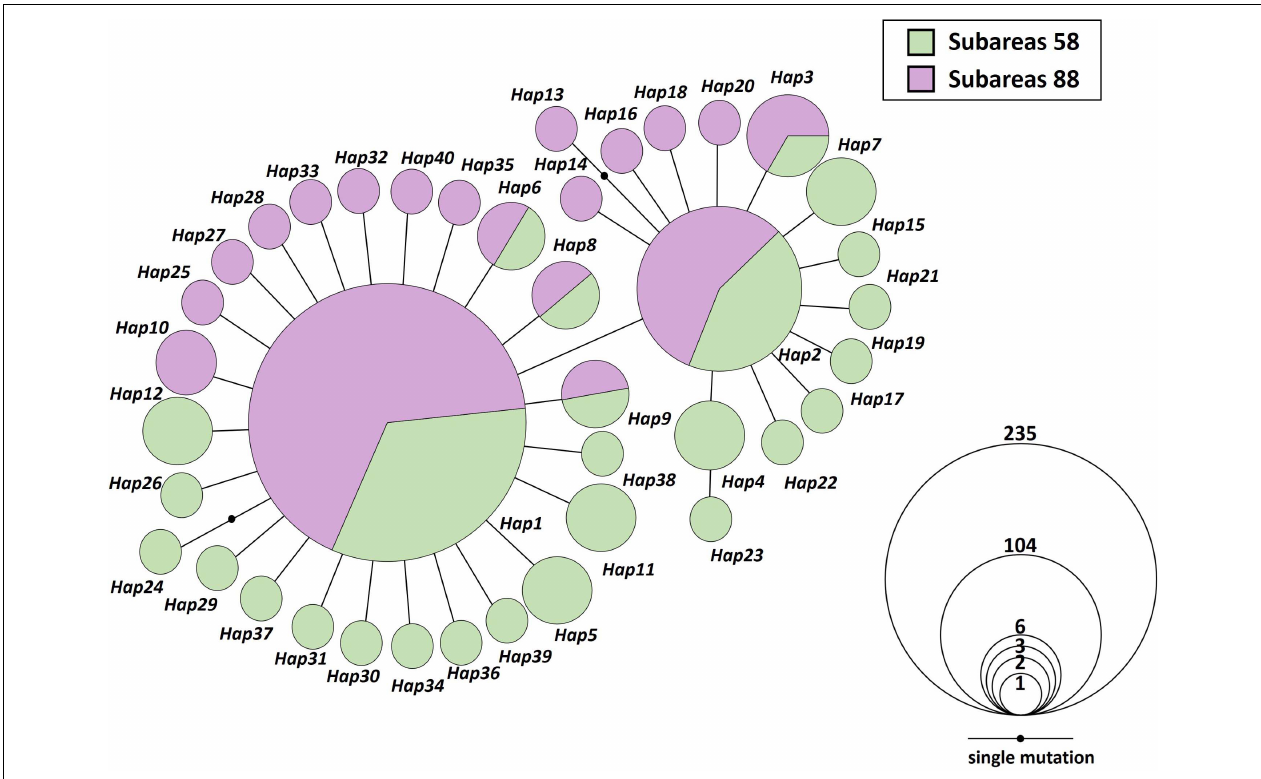
FIGURE 2 | Mitochondrial DNA (MtDNA) COI and 16S haplotype network of 40 haplotypes from 20 Antarctic toothfish populations ( N = 392). Each color indicates two different sampling regions (green; Subareas 58, purple; Subareas 88). Each line in the network represents one mutational step between haplotypes. Circle size is proportional to the number of samples belonging to respective haplotype ( Hap1 : 235; Hap2 : 104; Hap3 : 6; Hap4 : 3; Hap5 , Hap6 , Hap7 , Hap8 , Hap9 , Hap10 , Hap11 , Hap12 : 2; the remaining 28 haplotypes: 1). Small black circles indicate an intermediate haplotype that is not present in our samples, but is necessary to construct the